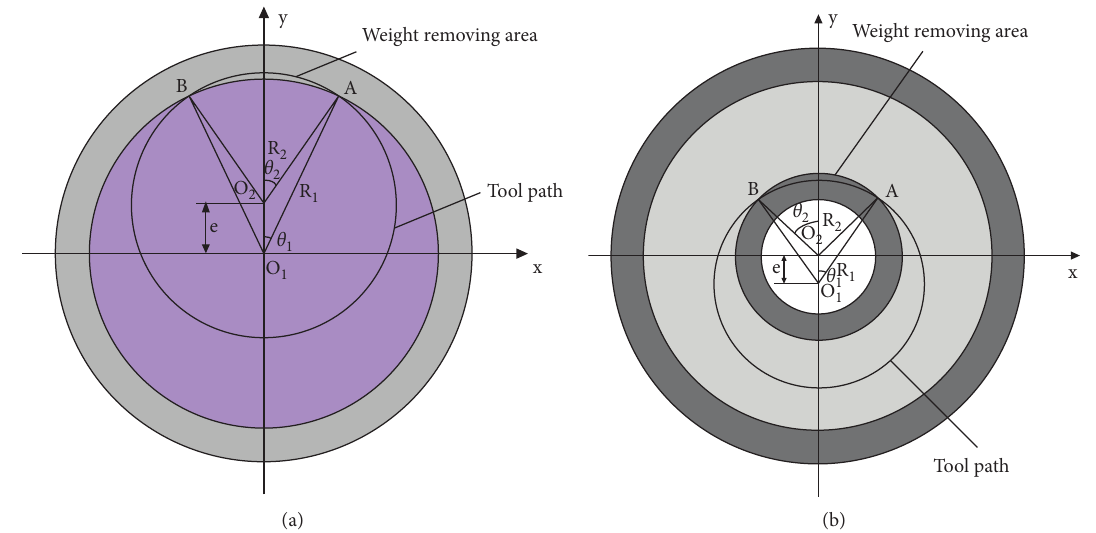
Figure 4: The geometric models of internal and external arc milling: (a) the internal arc milling model; (b) the external arc milling